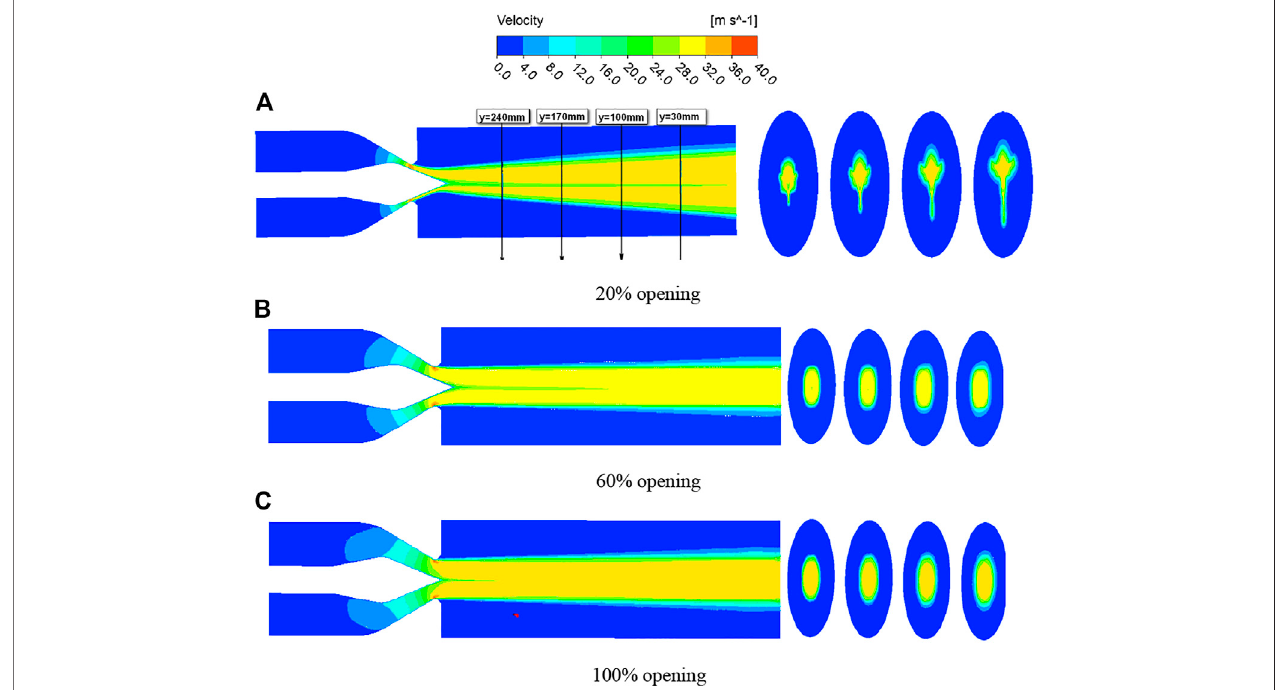
FIGURE 8 | Jet velocity cloud diagram at different opening degrees.